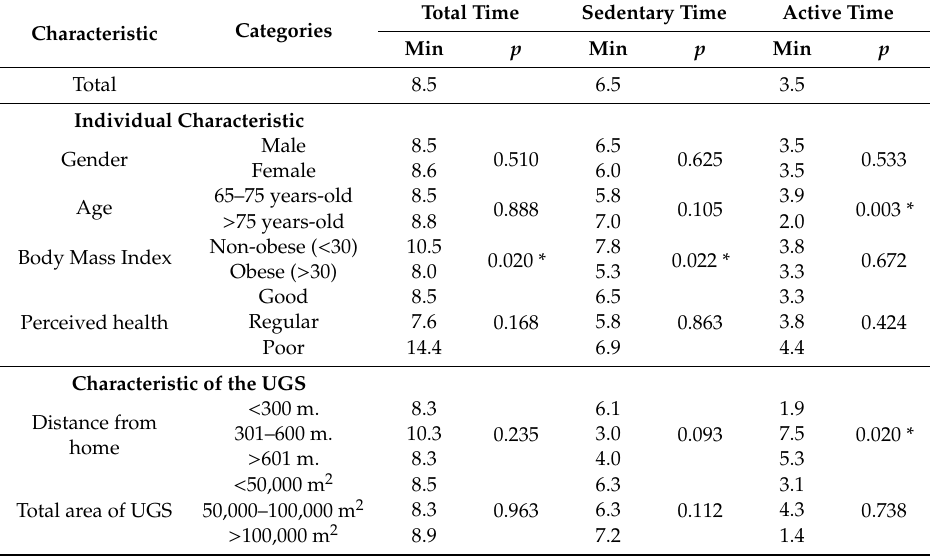
Table 2. Descriptive statistics of median time spent and intensity by individual and UGS-related